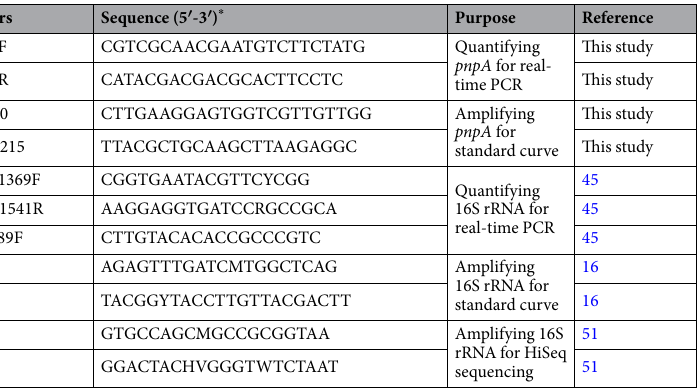
Table 1. Primers and probe used in this